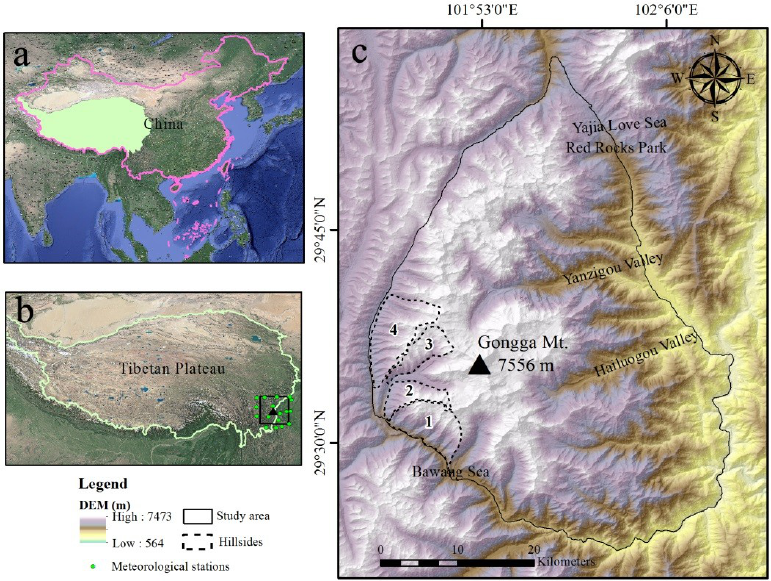
Figure 1. Location of the study area: ( a ) Tibetan Plateau in China; ( b ) Gongga Mountain on the Tibetan Plateau; ( c ) Gongga Mountain location. Note: the “1”, “2”, “3”, and “4” denote the selected hillsides (i.e., first, second, third, and fourth hillside). The first and the third slopes denote sunny slopes, the second slope denotes a shady slope, and the fourth hillside denotes a mixed slope.